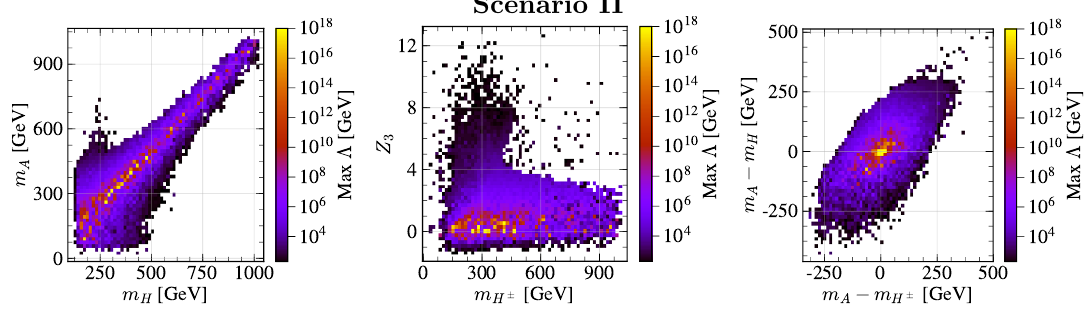
Figure 6 . Maximum breakdown energy scale as function of scalar masses in scenario II. (Left): masses of scalar H and pseudo-scalar A Higgs bosons. (Middle): Z 3 vs. charged Higgs mass m (Right): mass